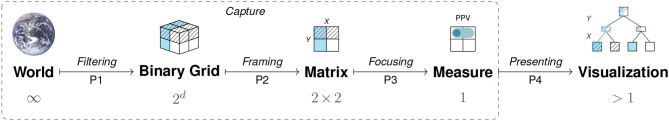
The matrix lens model describes scientific inquiries that reduce complexity in several steps by adopting increasingly specific perspectives on particular aspects of the world. Its initial steps reduce the dimensions of explicitly represented information by filtering, framing, and focusing (P1–P3) to capture a particular measure (e.g., a diagnostic test's positive predictive value, PPV). By contrast, the final step of presenting (P4) can widen the scope by creating representations that are transparent when explicating the perspectives adopted during the measure's derivation.